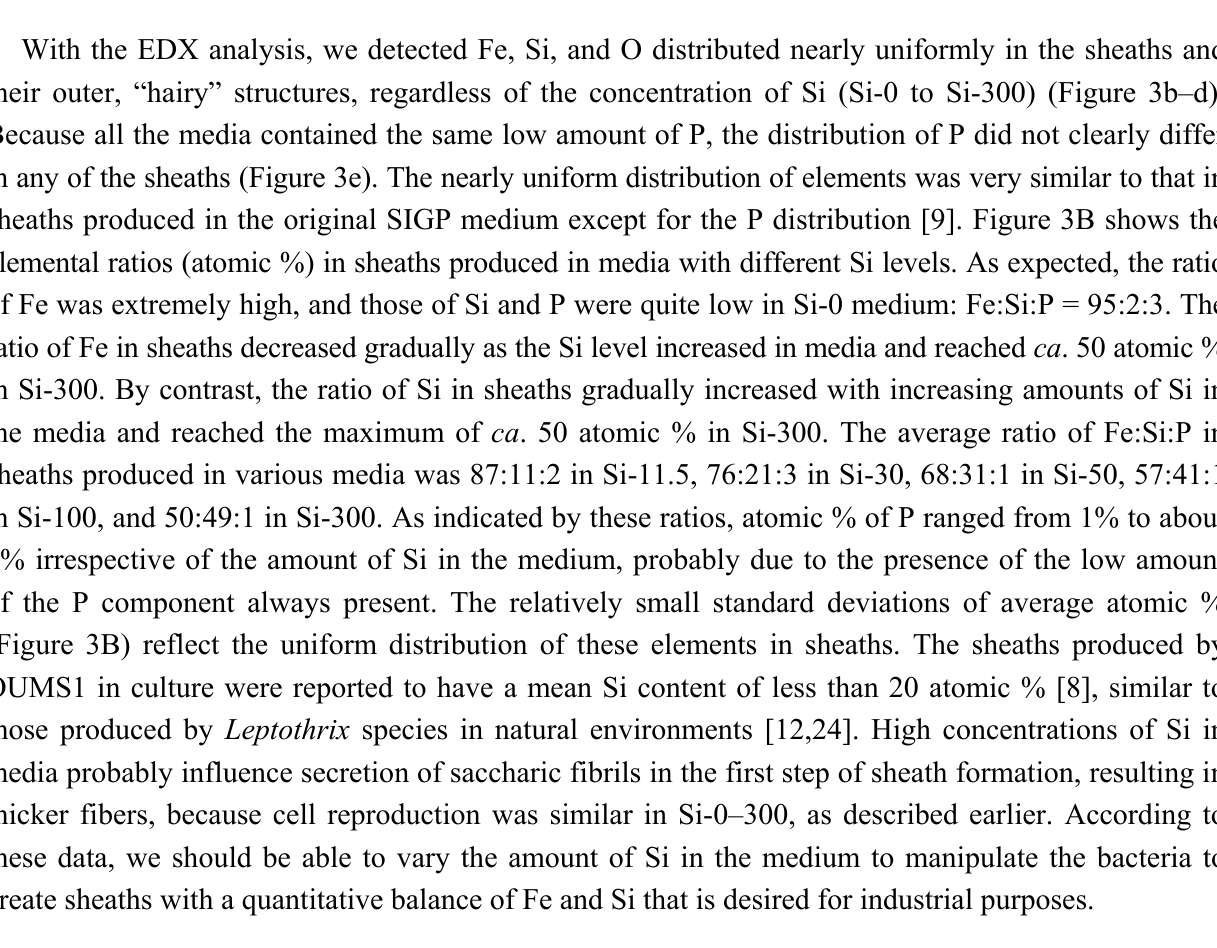
Figure 3. ( A ) Elemental mapping of the cultured sheath of Si-300 (Fe:Si:P = 50:49:1) obtained by energy dispersive X-ray (EDX) area analysis. ( a ) HAADF-STEM image of a microtubule produced in Si-300. ( b – e ) Distribution maps of Fe, Si, O, and P, respectively, in the view area of ( a ). ( B ) Average ratios of Fe, Si, and P in the sheaths in media with various amounts of Si. Fe: black triangle, Si: blue circle, P: red